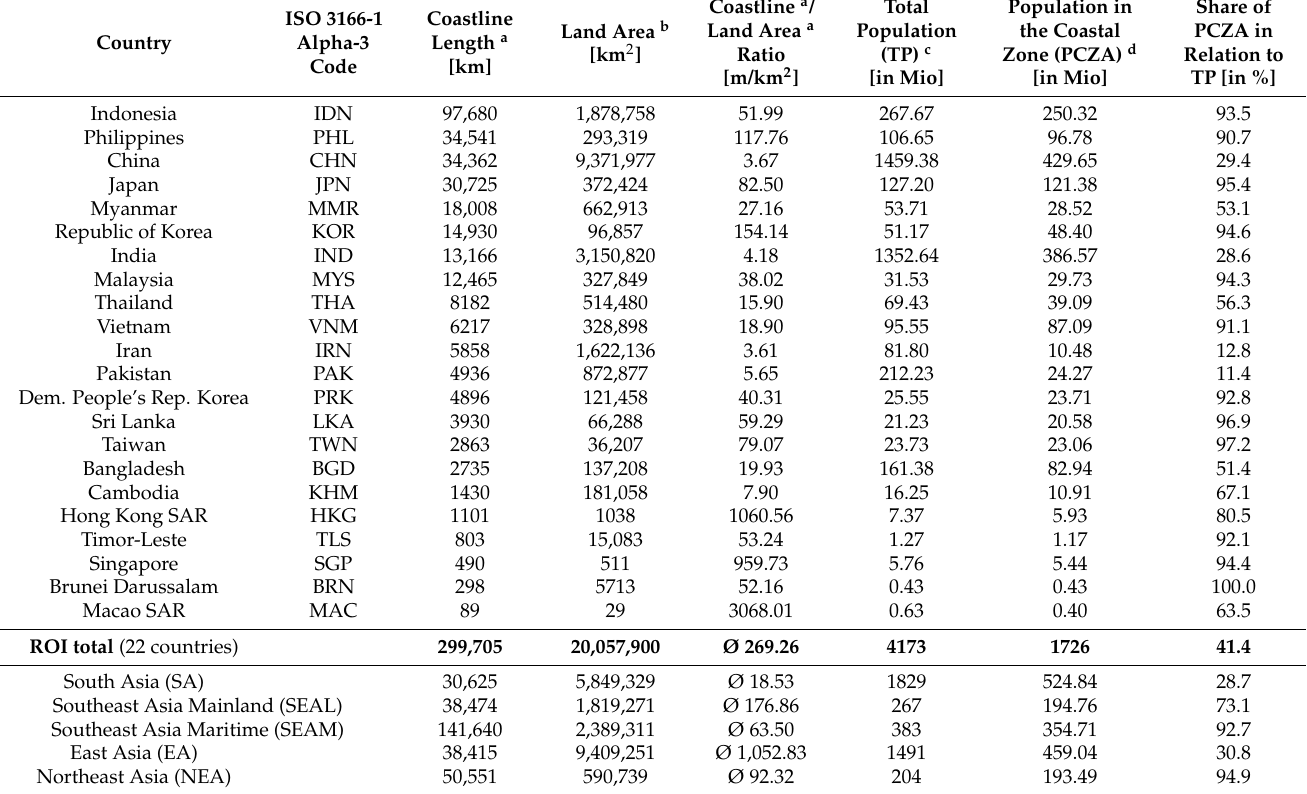
Table 1. Overview of all countries that belong to the study region: coastal zone of Asia (CZA).